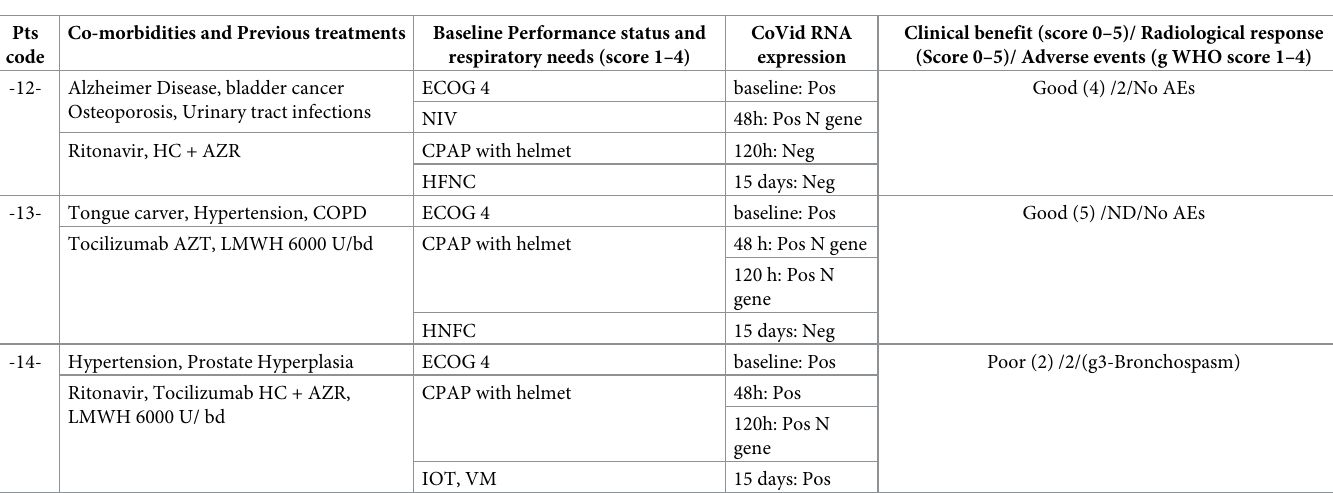
from the beginning of the treatment, thus fulfilling the statistically endpoint of this preliminary analysis that was pre-fixed at 72%. In particular, the average PaO cant increase from 215 ± 45 to 464 ± 136, P = 0.0002 in 120 hours (Fig 1A) with a median time